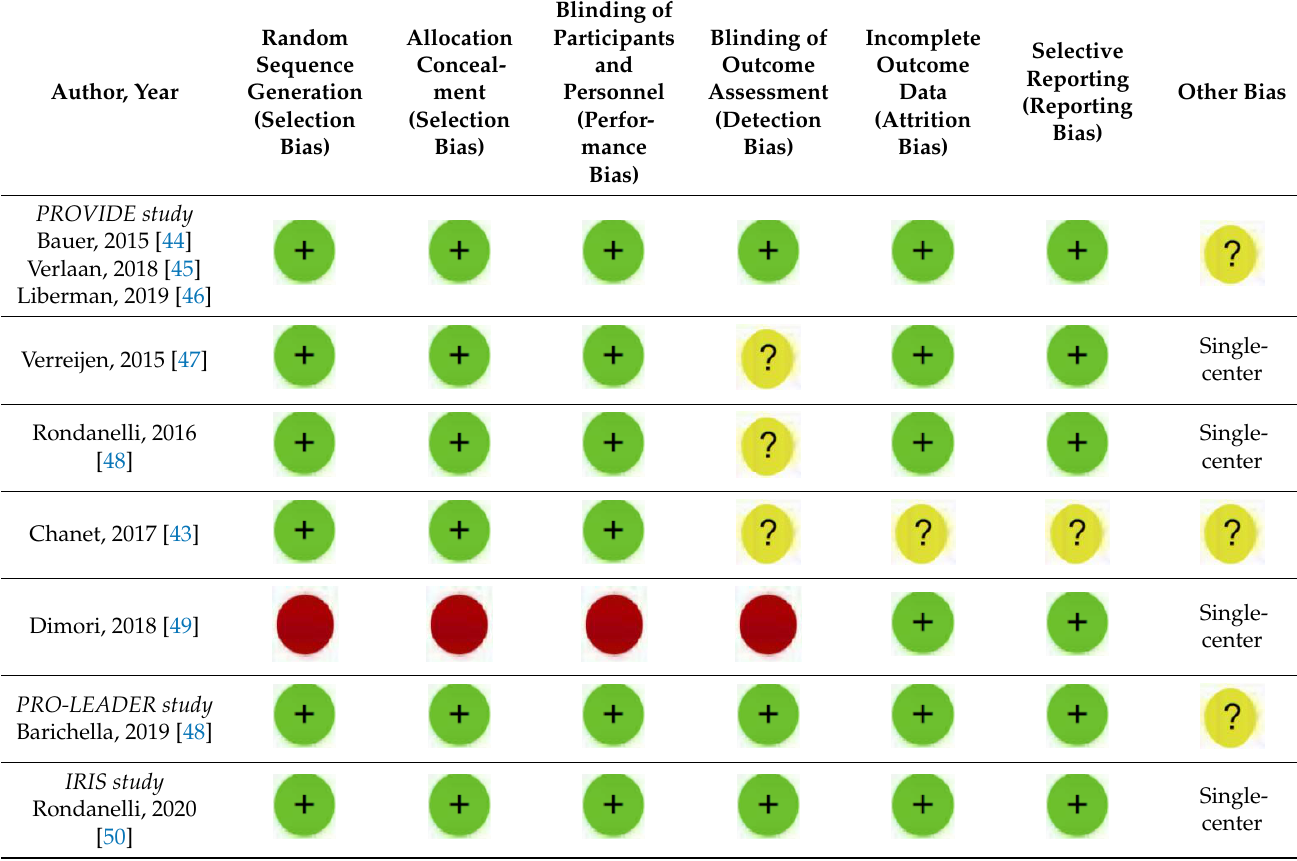
Table 2. Risk of bias of the clinical trials included in the review.